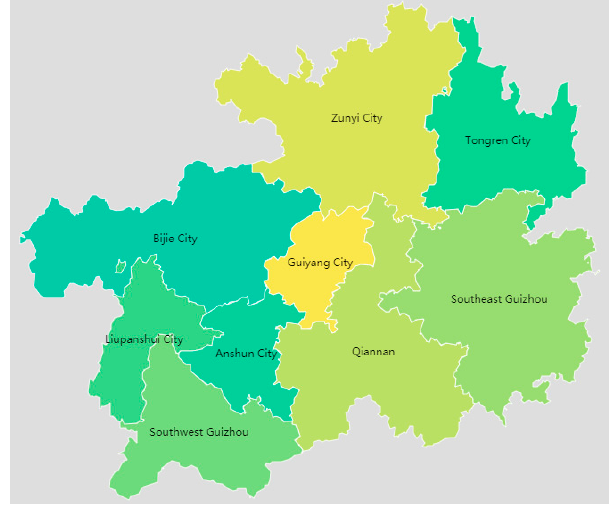
Figure 3. Geographical location distribution map of various cities (prefectures) in Guizhou province.